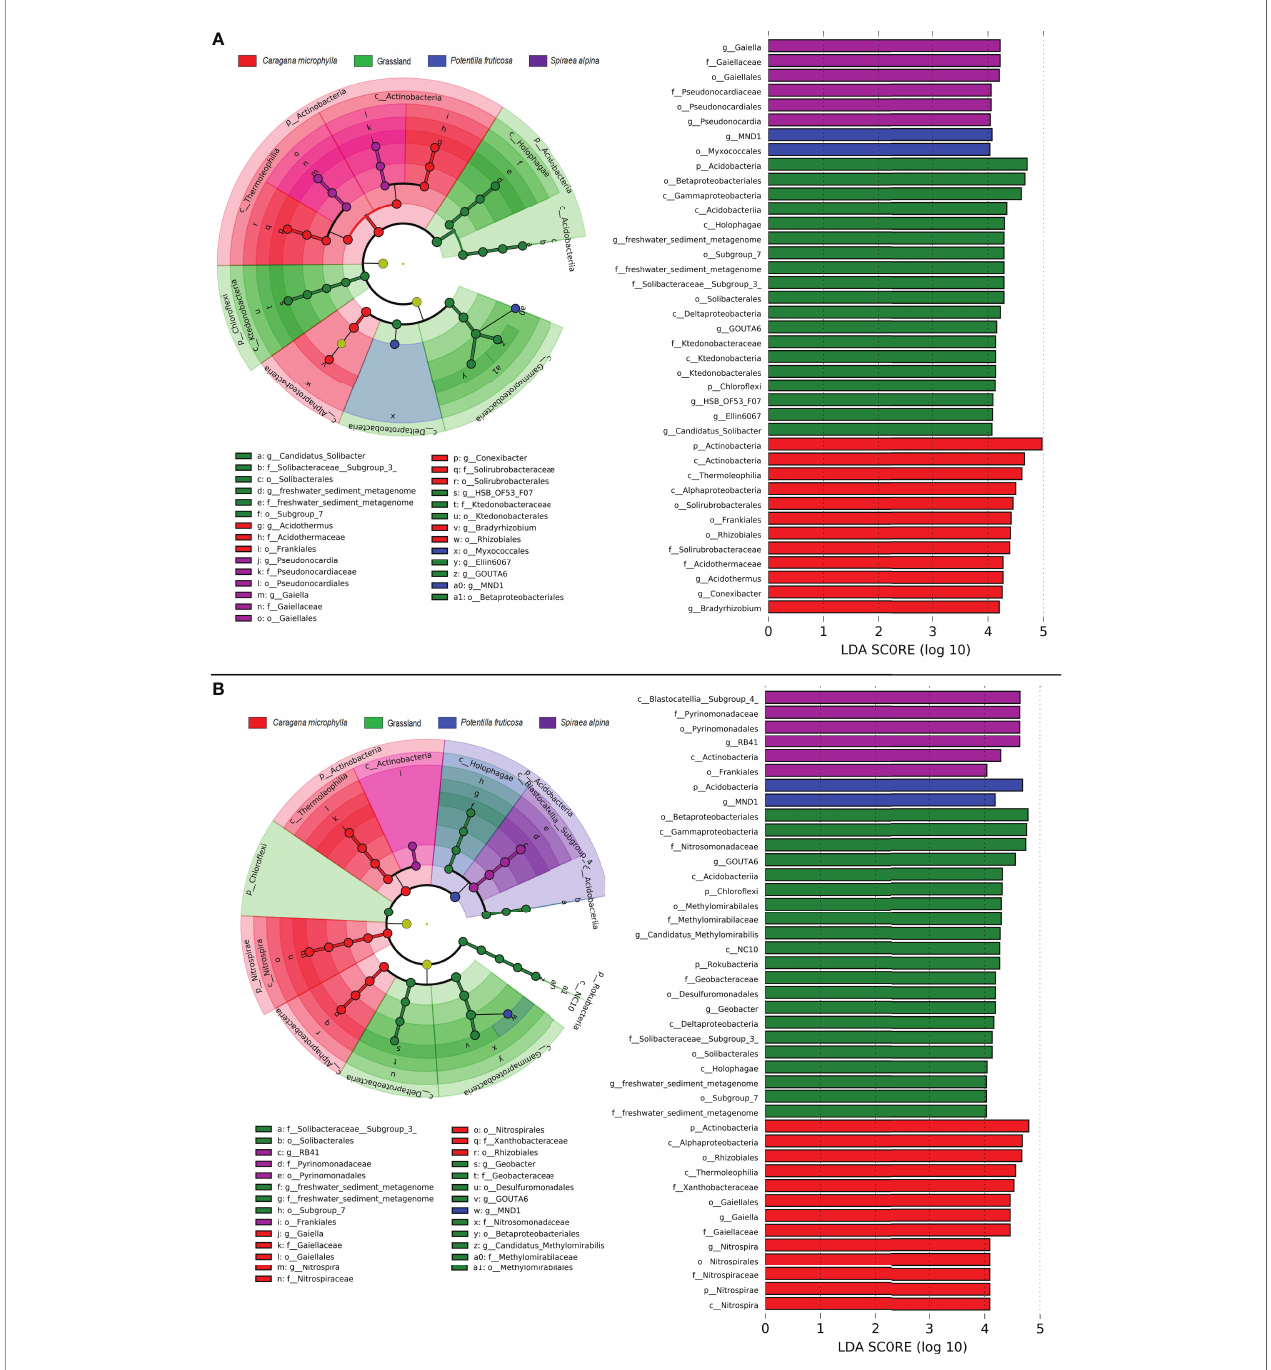
FIGURE 7 | LEFSe analysis of biomarkers in the four groups of soil bacteria. (A) Surface layer; (B) Deep layer. Cladogram representing the taxonomic hierarchy of biomarkers for four soil types. The circles radiating from the inside to the outside represent taxonomic levels from phylum to genus. LDA score >4 indicates a biomarker with statistical differences among the